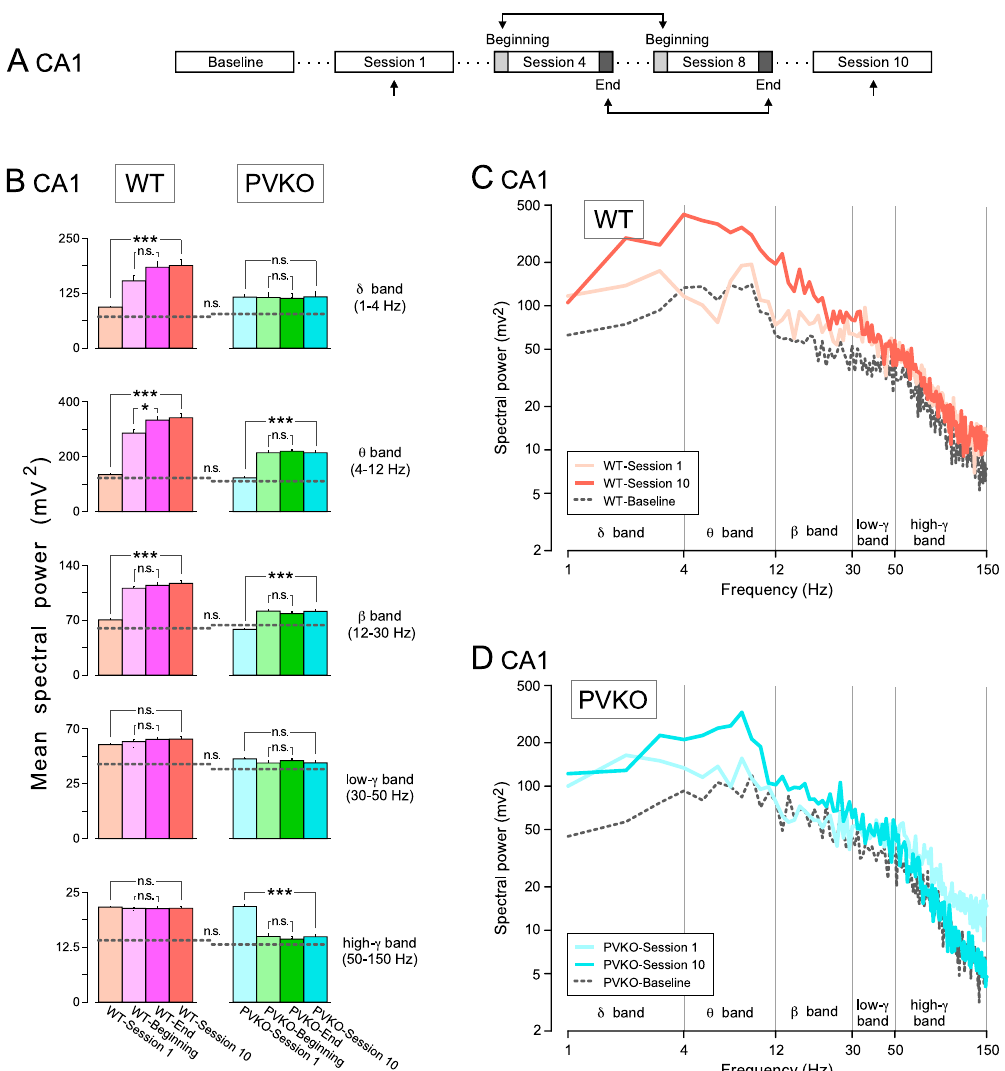
Figure 8. Spectral analyses of LFPs recorded in the hippocampal CA1 area across the successive operant conditioning sessions. ( A ) Experimental design. ( B ) Power histograms for the five selected frequency bands of LFPs recorded in the CA1 from WT (orange and pink) and PVKO (blue and green bars) mice during the 1st session , at the beginning of the 4th–8th sessions , at the end of the 4th–8th sessions and during the 10th sessions . Differences between the spectral powers in the selected frequency bands are indicated at the enclosed histograms for both WT and PVKO mice. The dotted lines across the histograms of each frequency band correspond to the mean power of the baseline condition for the corresponding group of mice. Note the larger spectral powers presented by LFPs collected from WT mice for the five selected frequency bands. Tukey-Kramer multiple comparisons test: n.s., non-significant difference; * P < 0.05 ; ** P < 0.01 ; *** P < 0.001 (for details see Supplementary Tables S6.1–S6.3). ( C ) Mean power spectra of LFPs recorded in the CA1 from WT mice during the baseline condition and during the 1st session (light orange trace) and during the 10th session (dark orange trace). ( D ) Mean power spectra of LFPs recorded in the CA1 from PVKO mice during the baseline condition and during the 1st session (light blue trace) and during the 10th session (dark blue